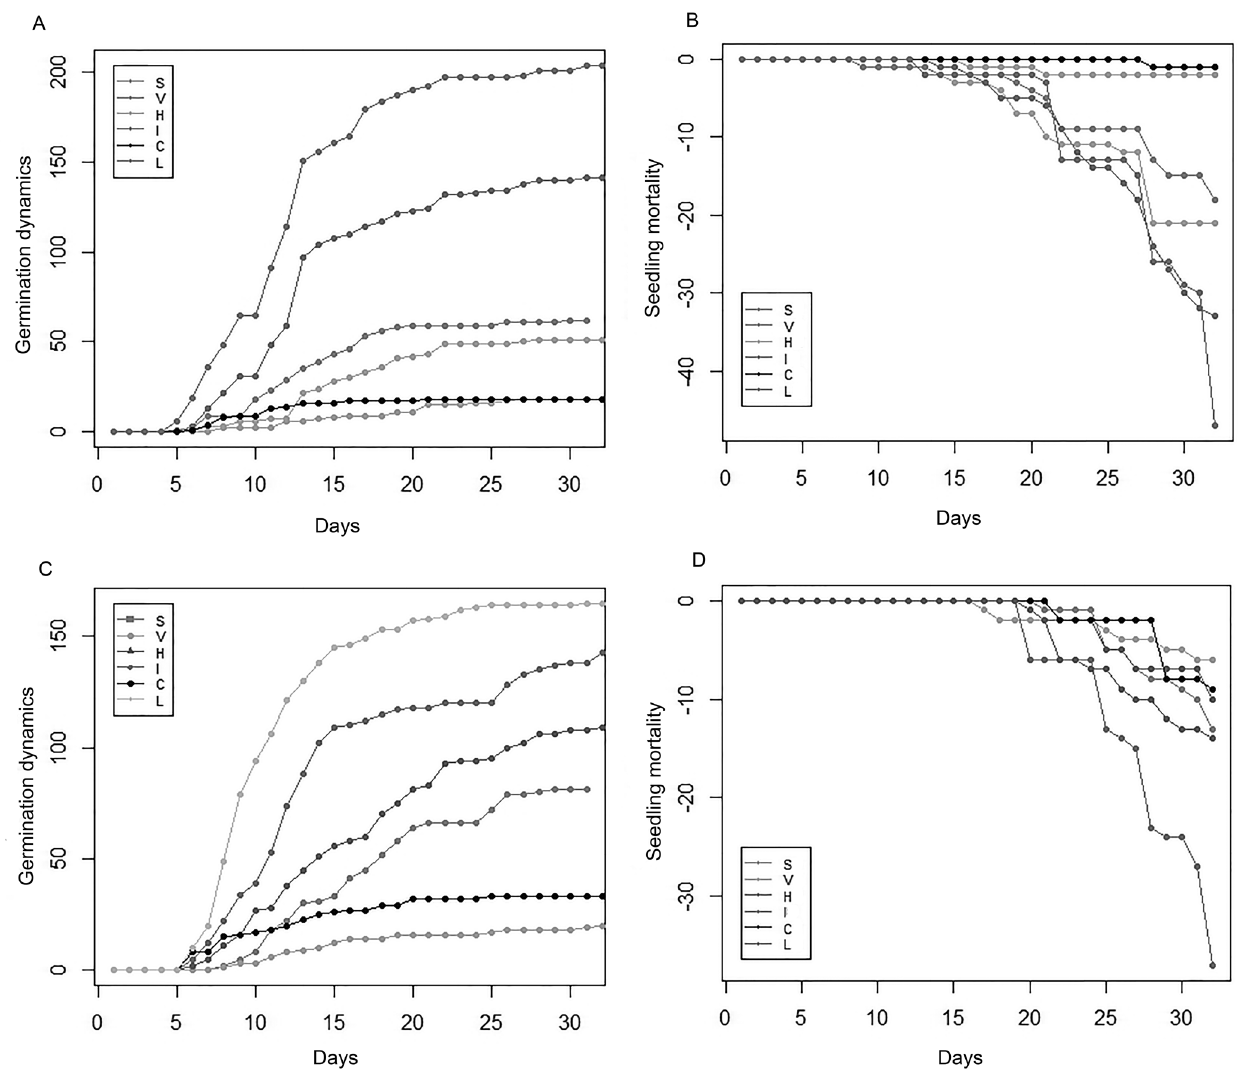
Figure 2 – Germination dynamics and seedling mortality: A & B, cold-stored seeds; C & D, seeds stored at room temperature (S –